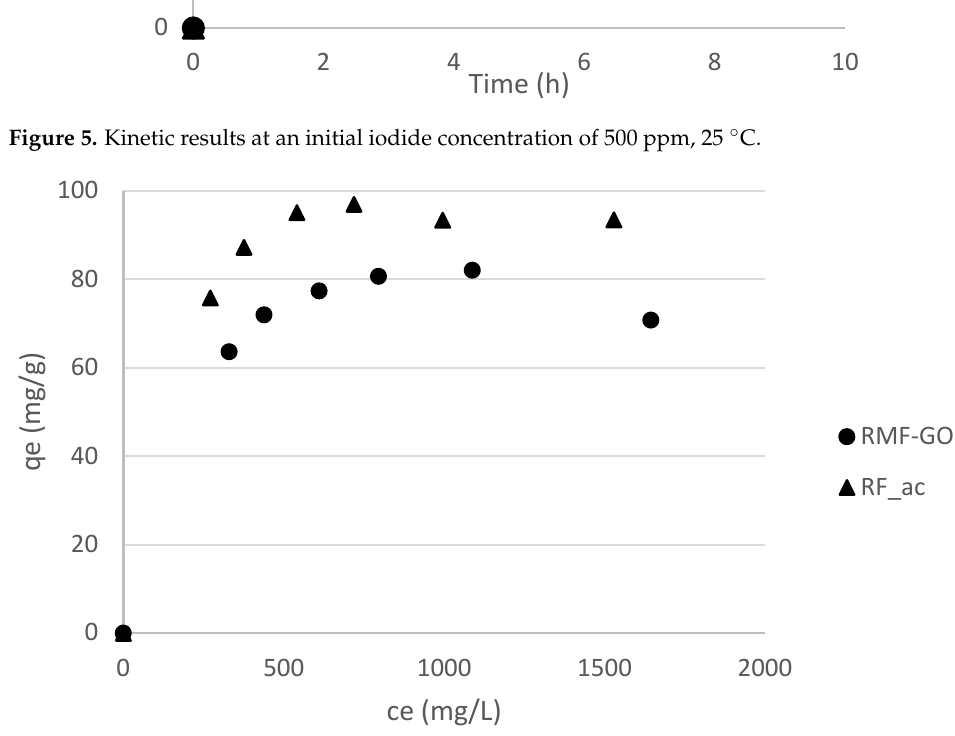
Figure 5. Kinetic results at an initial iodide concentration of 500 ppm, 25 °C.